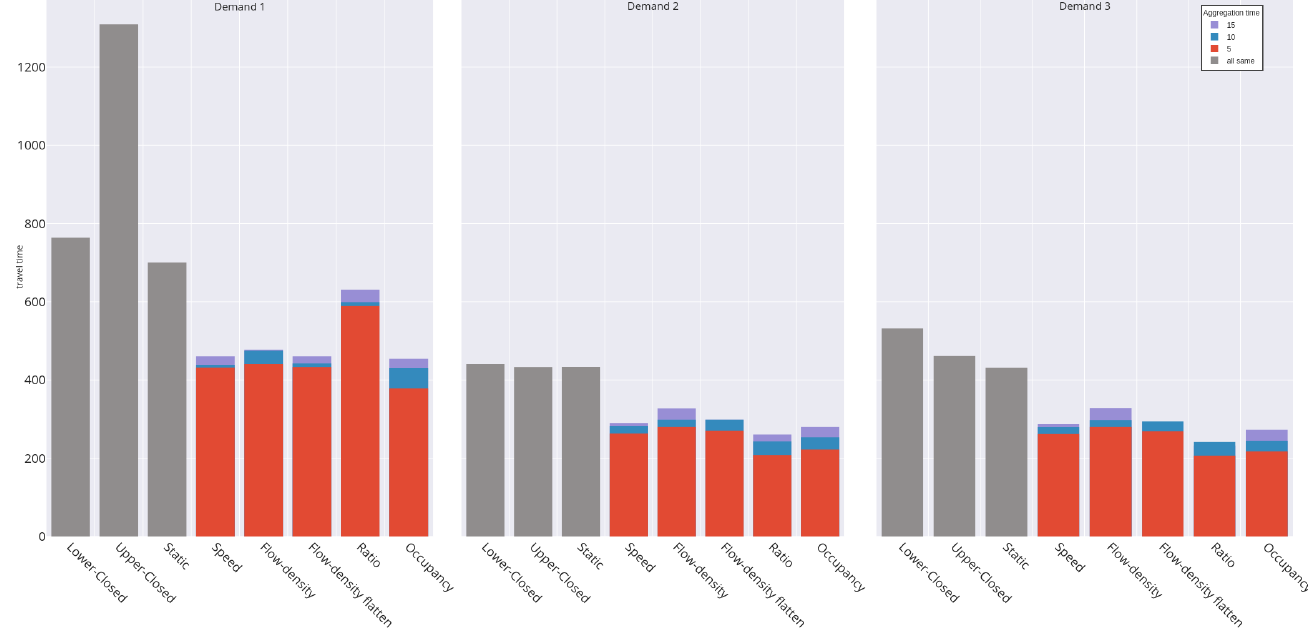
Figure 12. Travel times in seconds for the three demands for the 1-Intersection model. The red bar chart represents the 5 min aggregation time, the blue one represents the 10 min aggregation time, and the purple one represents the 15 min aggregation time. They are placed on top of each other to demonstrate the difference in aggregation times. The grey bars represent the base cases, where no algorithm is applied. Each demand is shown in its own bar chart, allowing them to be compared.